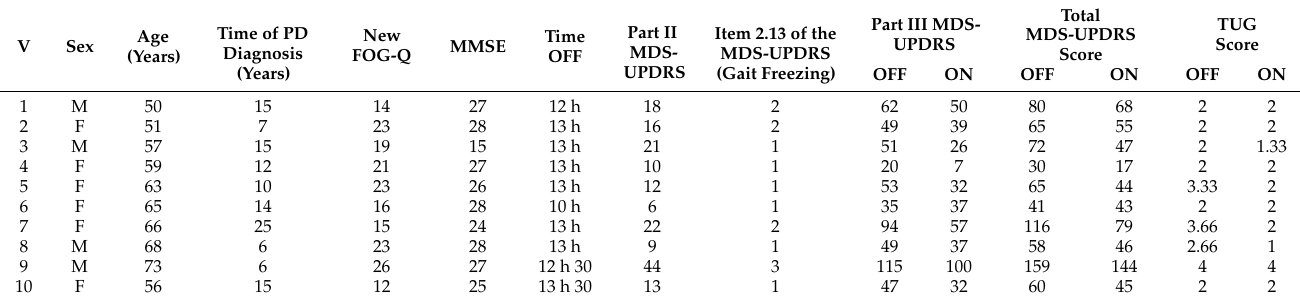
Table 2. Clinical characteristics of